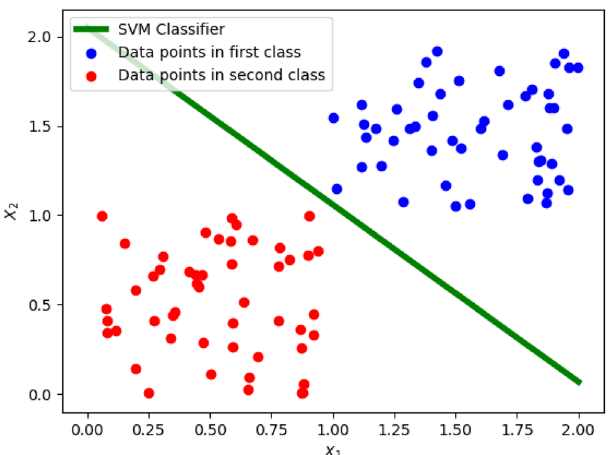
Figure 2. SVM model (green line) correctly classifying training data (red and blue